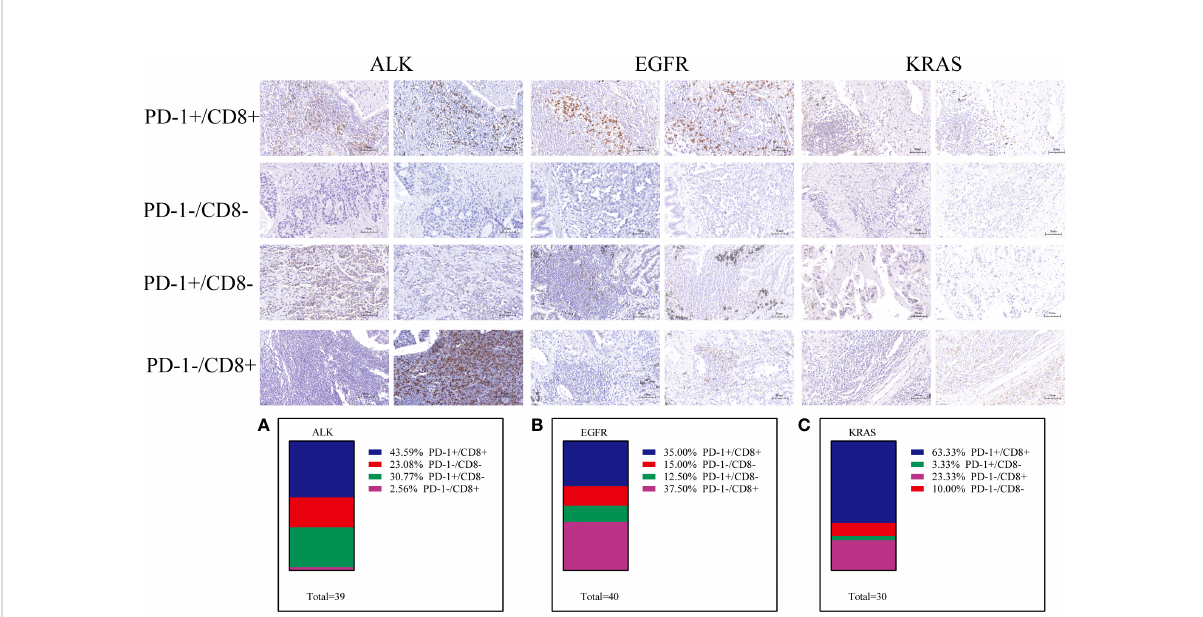
FIGURE 3 Differential proportion of PD-1+/CD8+, PD-1-/CD8-, PD-1+/CD8-and PD1-/CD8+ in ALK-positive (A) , EGFR-positive (B) and KRAS-positive (C) NSCLC. Low (-) and High (+)